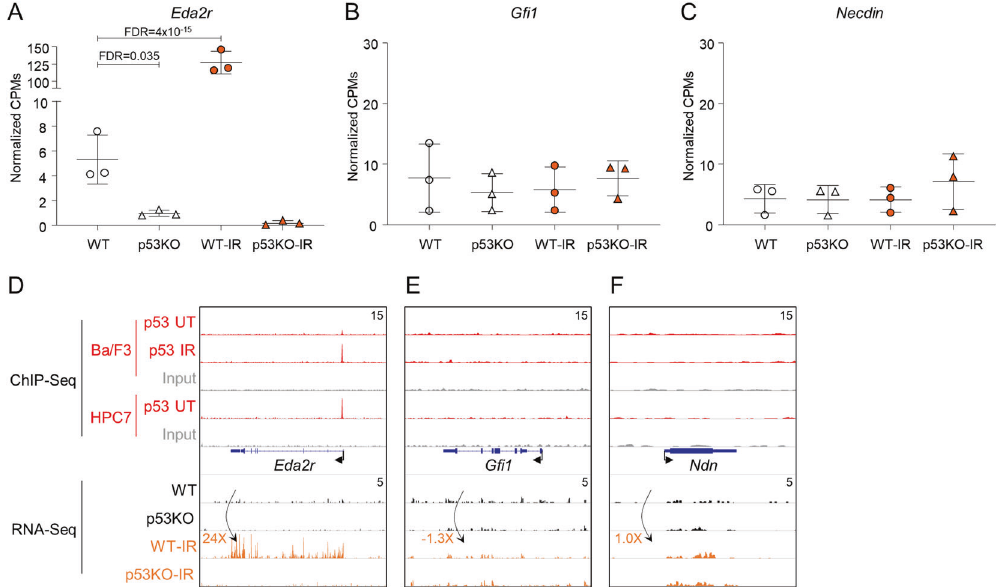
Fig. 4 Characterization of the p53-regulated genes in HSPCs under homeostatic conditions. A – C Normalized counts per million (CPM) expression of Eda2r , G fi 1 , and Ndn genes from the RNA-Seq of murine WT and p53KO HSPCs with and without whole-body irradiation. D – F Genomic snapshots of Eda2r , G fi 1 , and Ndn genes. ChIP-Seq tracks of p53 in untreated (UT) and irradiated (IR) hematopoietic progenitor cells Ba/F3 and HPC7, and input DNA from the same cells are shown in the top fi ve lanes. The gene feature track is shown in the middle. RNA-Seq tracks of the summation of gene expression in each group are shown in the bottom four lanes. The maximum data range of each track is indicated at the top-right corner of the